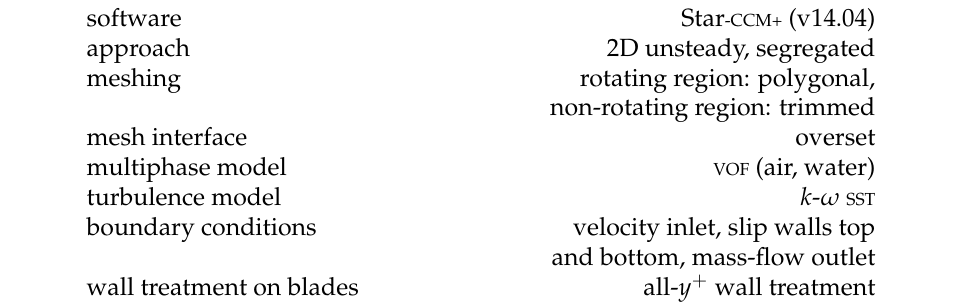
Table 1. Numerical settings of reference simulation model used in this study. All settings are carried over from References [16,17], where they were discussed in greater